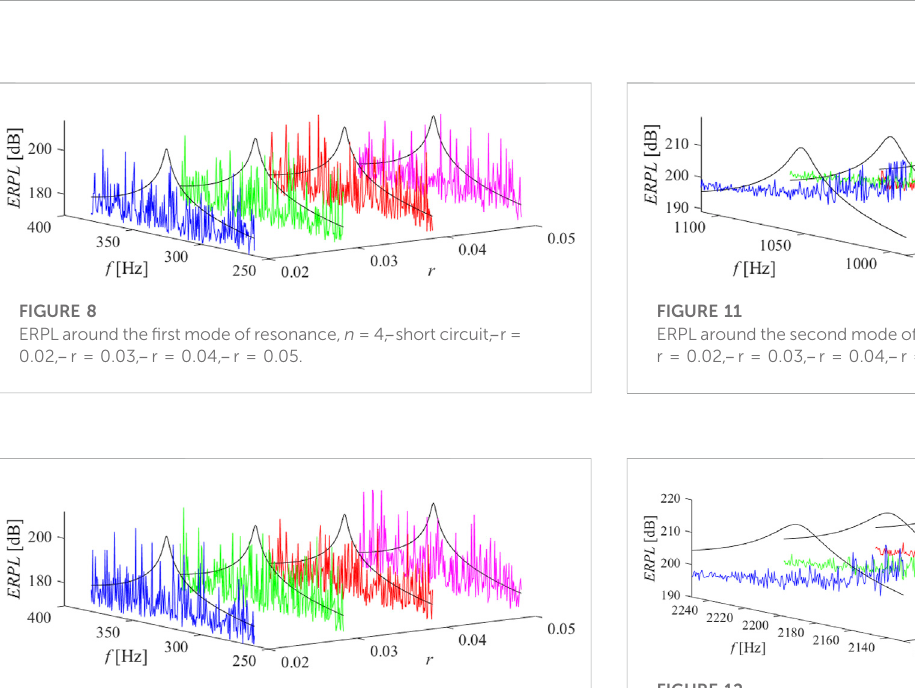
FIGURE 9 ERPLaroundthe fi rst modeofresonance, n =5, ̶ shortcircuit, ̶ r = 0.02, ̶ r = 0.03, ̶ r = 0.04, ̶ r = 0.05.